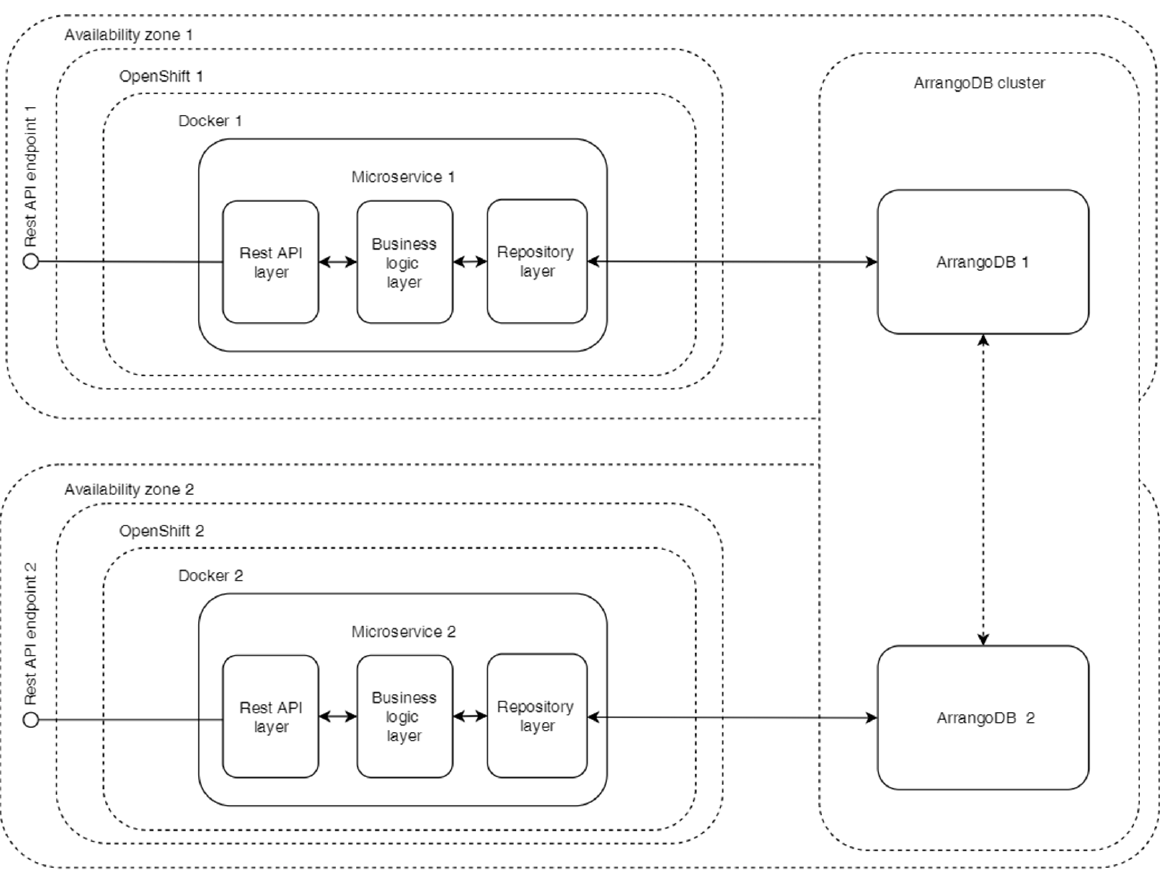
Figure 19. The simplified model of a new SSI application with multi-model polyglot persistence.